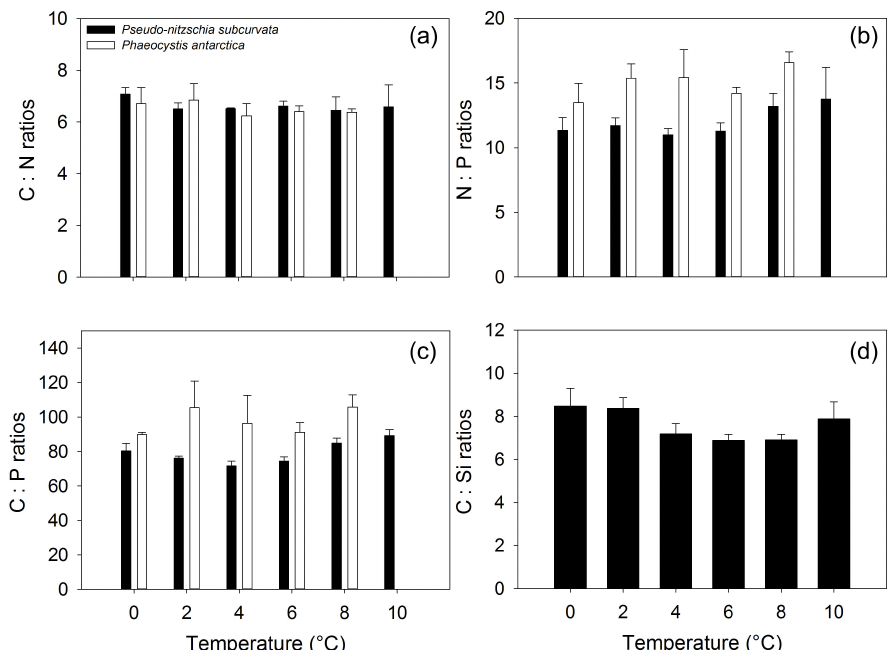
Figure 2. The C:N ratios (a) , N:P ratios (b) , and C:P ratios (c) of Pseudo-nitzschia subcurvata and Phaeocystis antarctica and (d) the C:Si ratios of Pseudo-nitzschia subcurvata from the thermal response curves shown in Fig. 1 for a range of temperatures from 0 to 10 ◦ C. Values represent the means and error bars represents the standard deviations of triplicate samples.